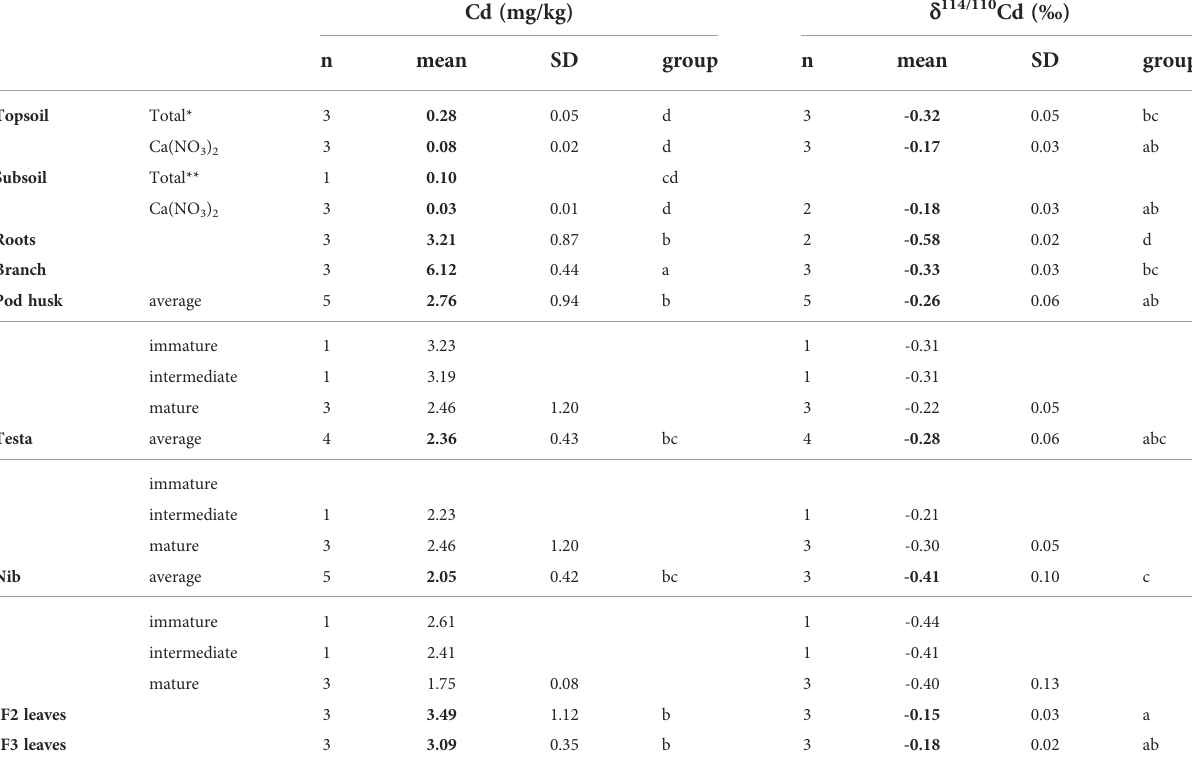
TABLE 2 Cd concentrations and isotope compositions (as d 114/110 Cd) for the soil and different cacao plant